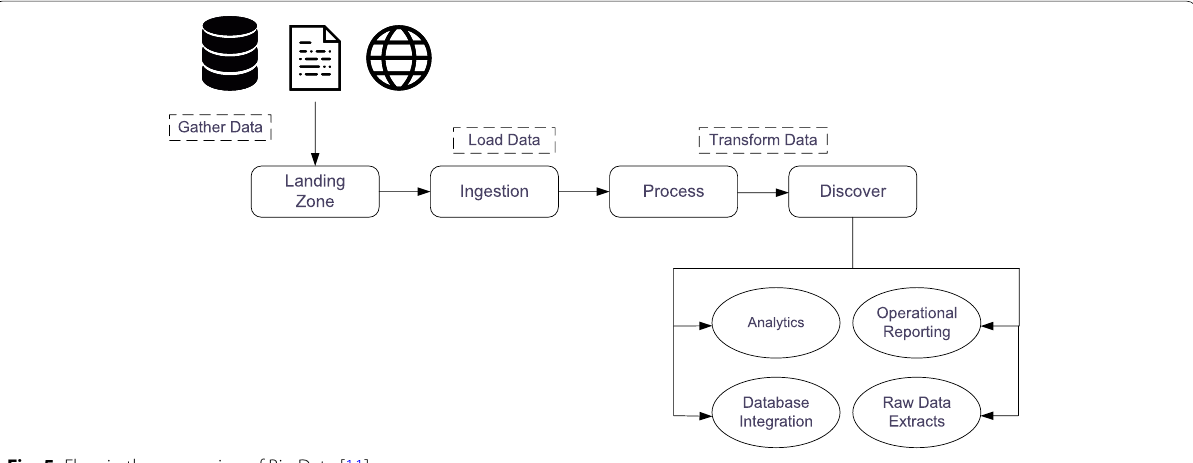
Fig. 5 Flow in the processing of Big Data